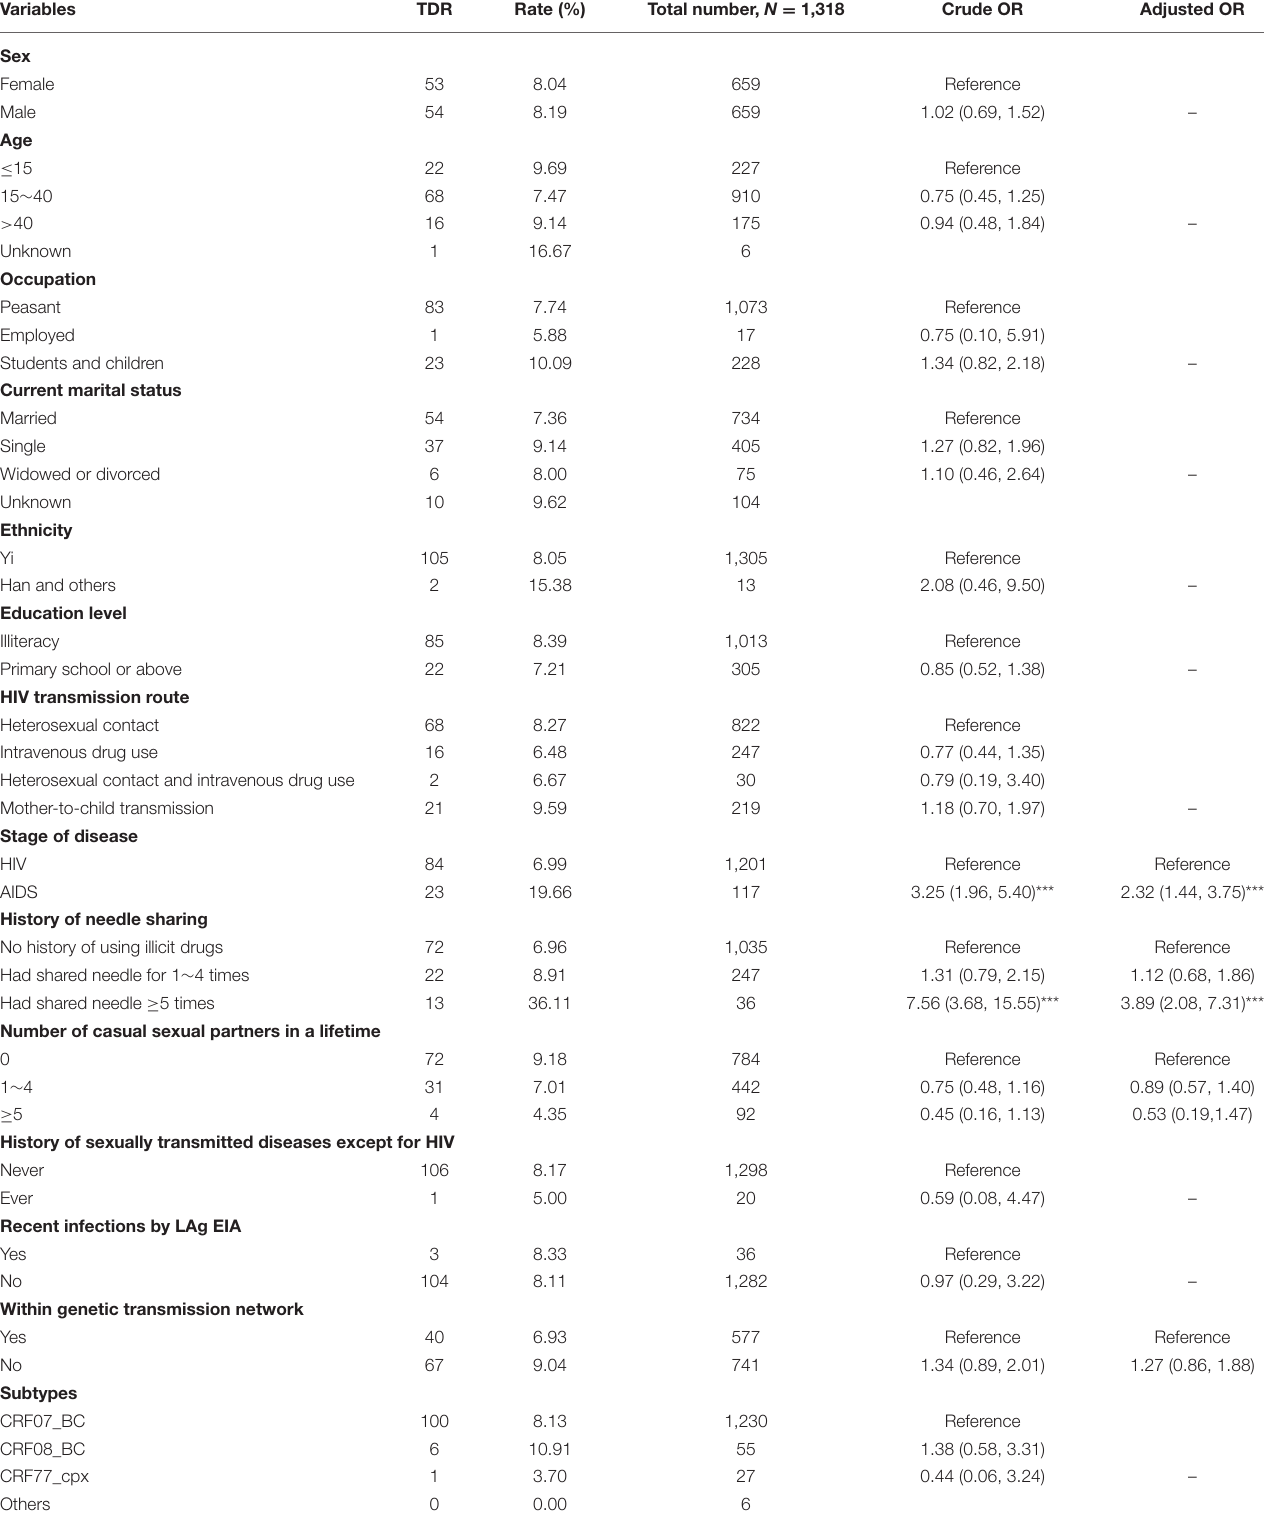
TABLE 1 | Prevalence and determinants of transmitted drug resistance (TDR) among the participants.